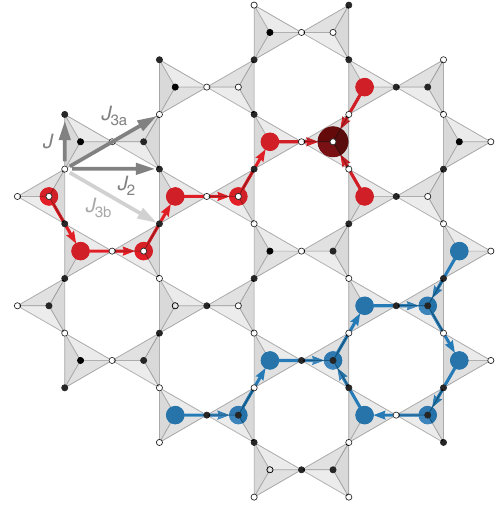
Figure 1 | Example of spin slush ground state. A spin slush ground state that includes all instances of the rules discussed in the main text. The first ( J ), second ( J 2 ) and third ( J 3a , J 3b ) neighbour exchange paths are indicated. The colours indicate s i ¼ ± 1 (black, white) for the pyrochlore sites, and the charge Q I for the dual lattice with Q I ¼ 0 (grey), Q I ¼ ± 1 (red, blue) and Q I ¼ ± 2 (dark red, dark blue). The arrow passes through the location of the minority spin for a single charge. This state contains branching lines of charge of both signs, a charge loop and a double-charge